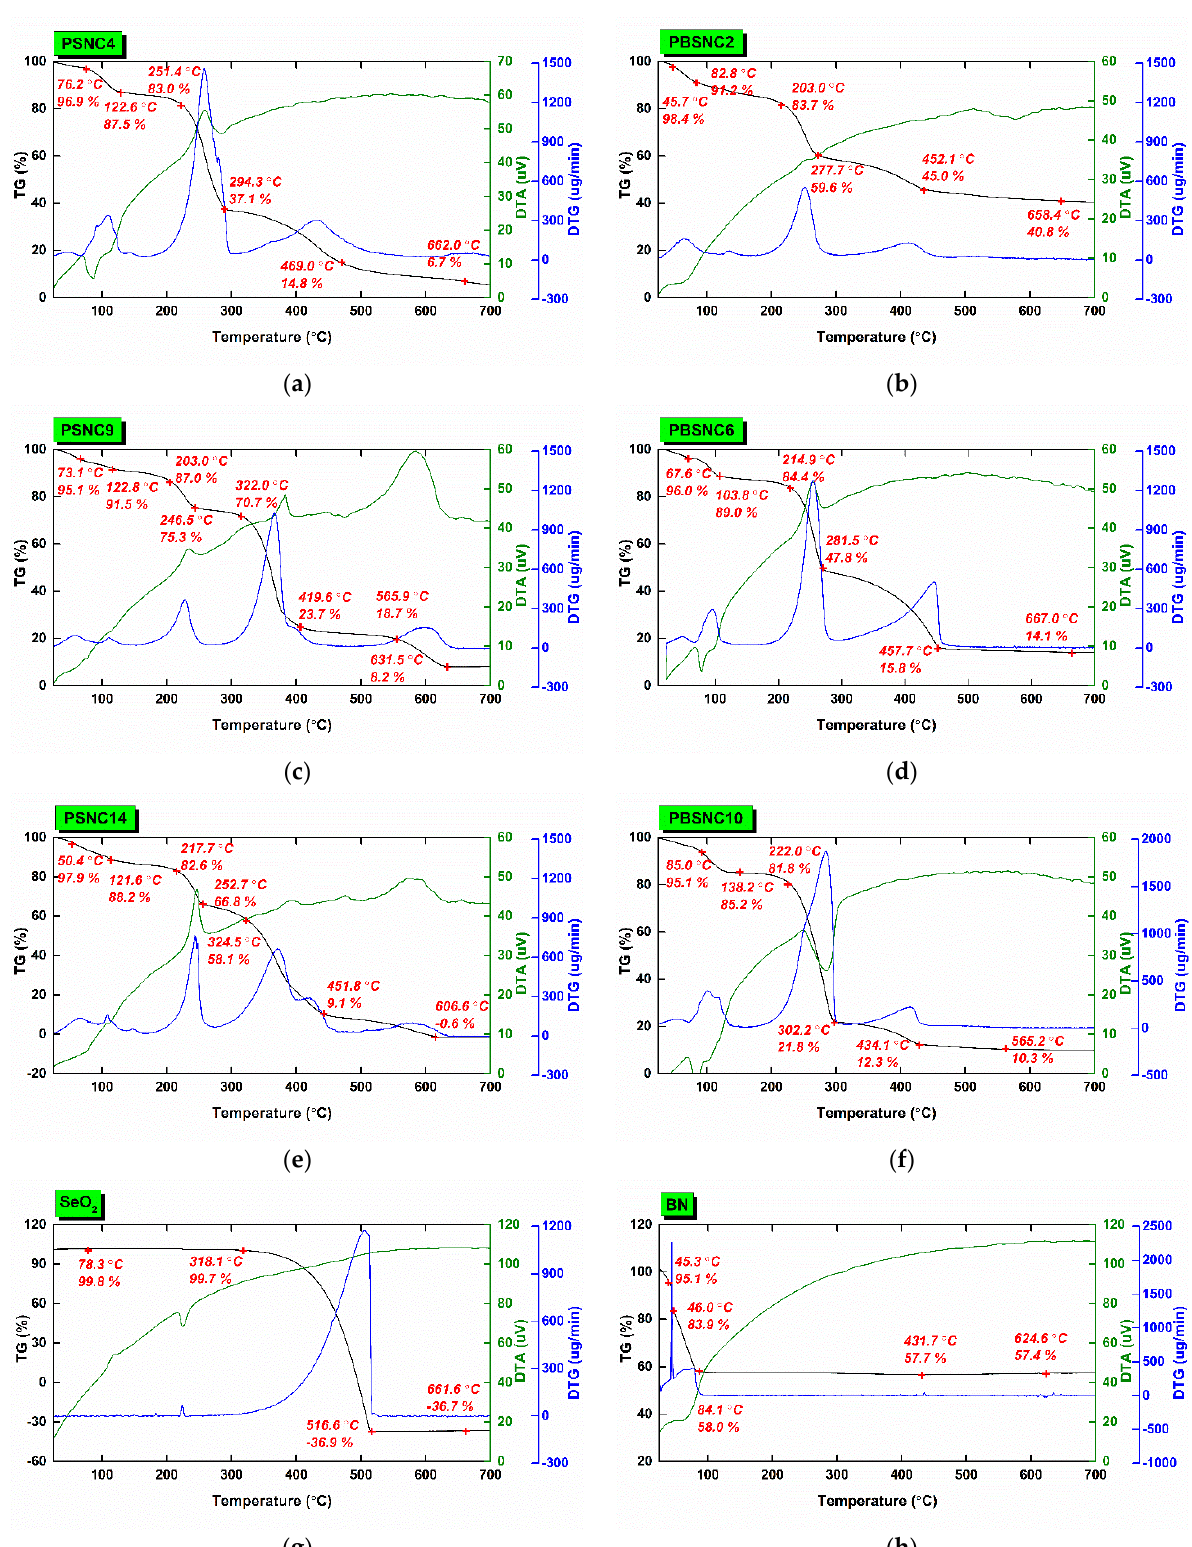
Figure 6. TGA outputs of the PS-b-PEG copolymers blended with the nanostructured SeO 2 and BN particles—PSNC4 ( a ); PBSNC2 ( b ); PSNC9 ( c ); PBSNC6 ( d ); PSNC14 ( e ); PBSNC10 ( f )—and TGA outputs of the pure nanostructured SeO 2 and BN particles: SeO 2 ( g ); BN ( h ).